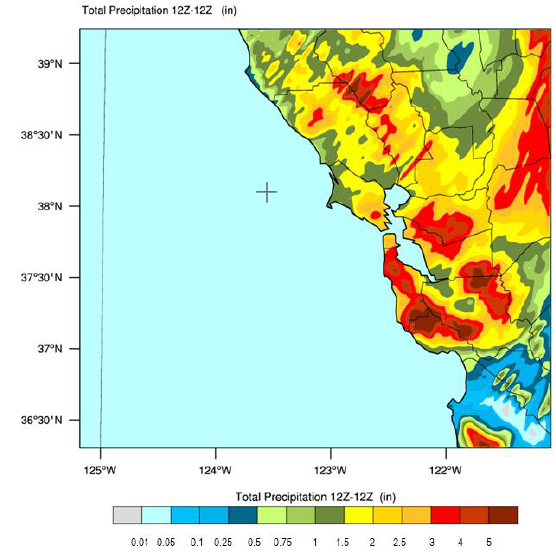
Figure 6. WRF-simulated total rainfall (inches) from 12Z–12Z on 20–21 February 2017.